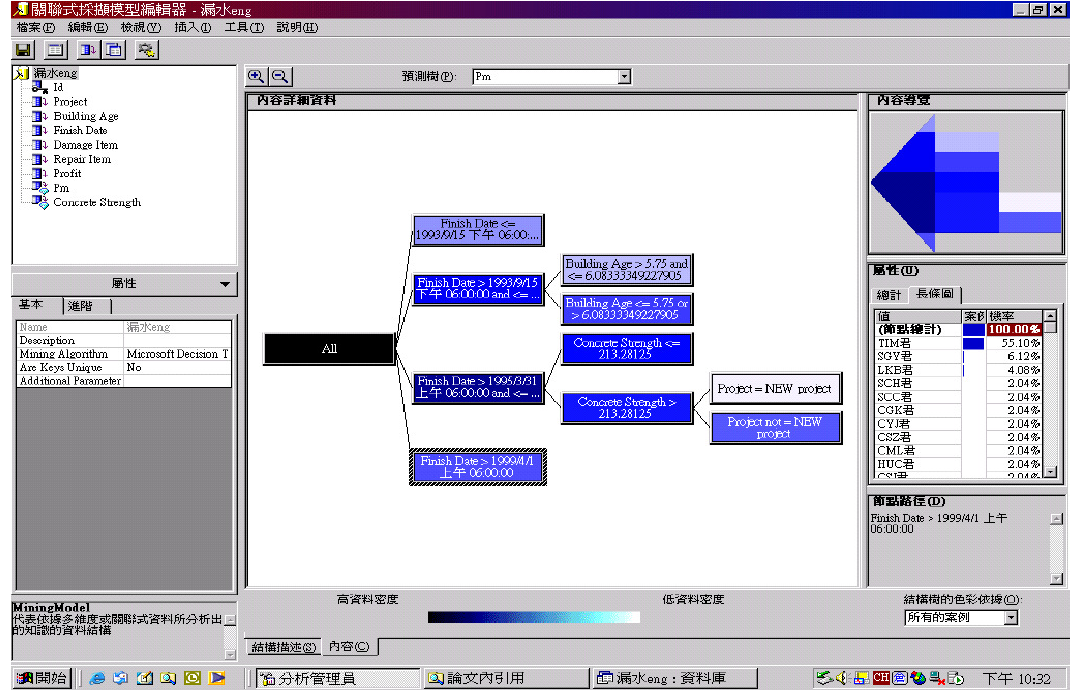
Fig. 3. Usage of project manager for decision tree